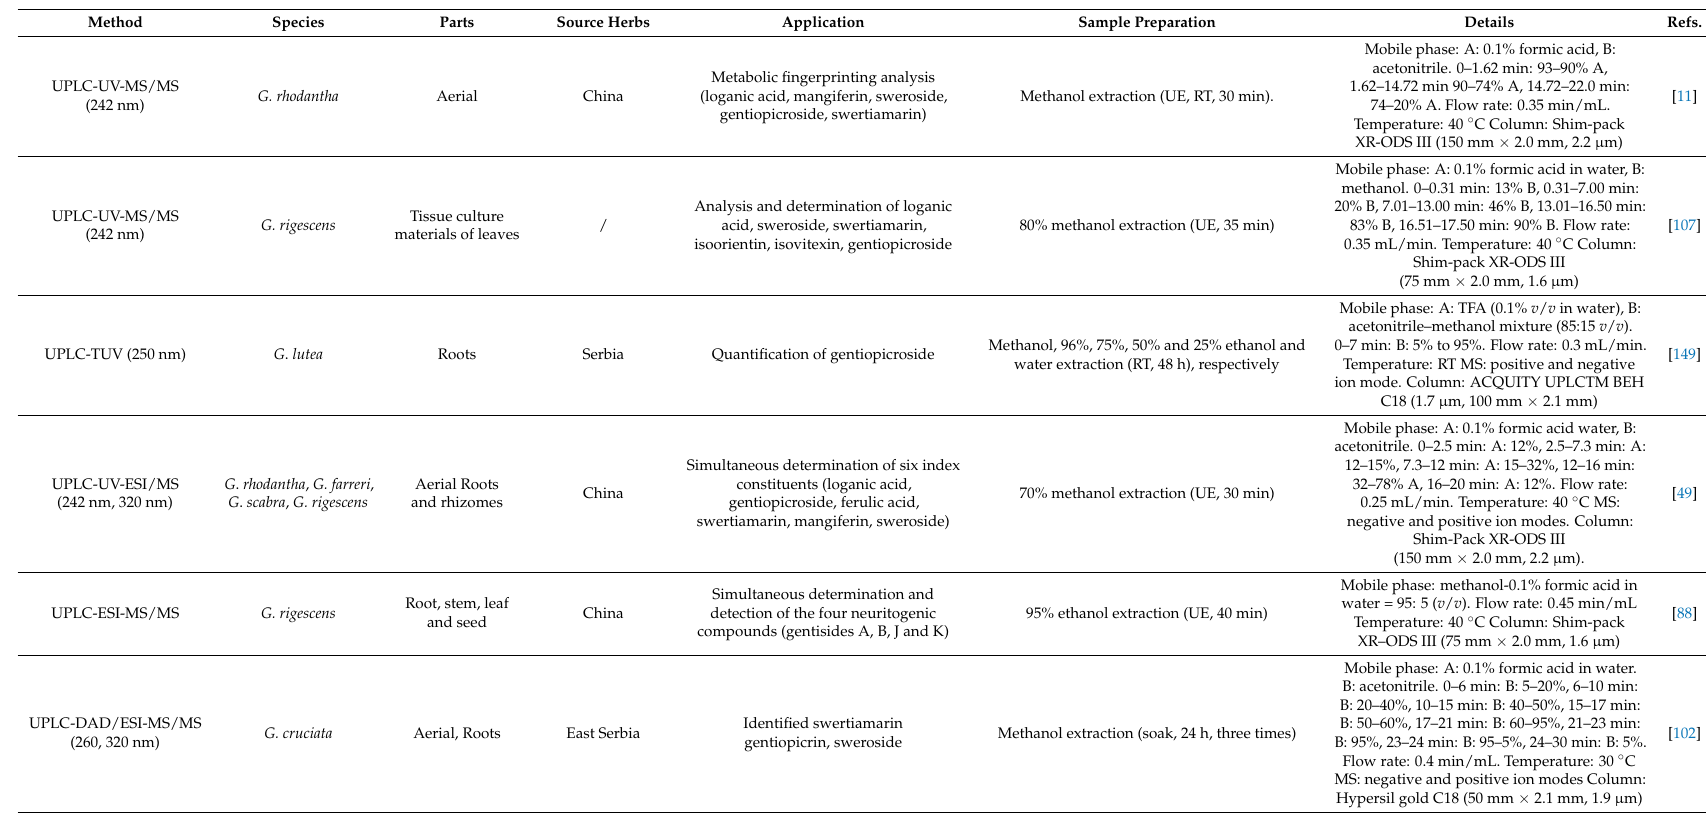
Table 4. Cont. Sample Preparation Details Refs. Metabolic fingerprinting analysis (loganic acid, mangiferin, sweroside, Methanol extraction (UE, RT, 30 gentiopicroside, swertiamarin)